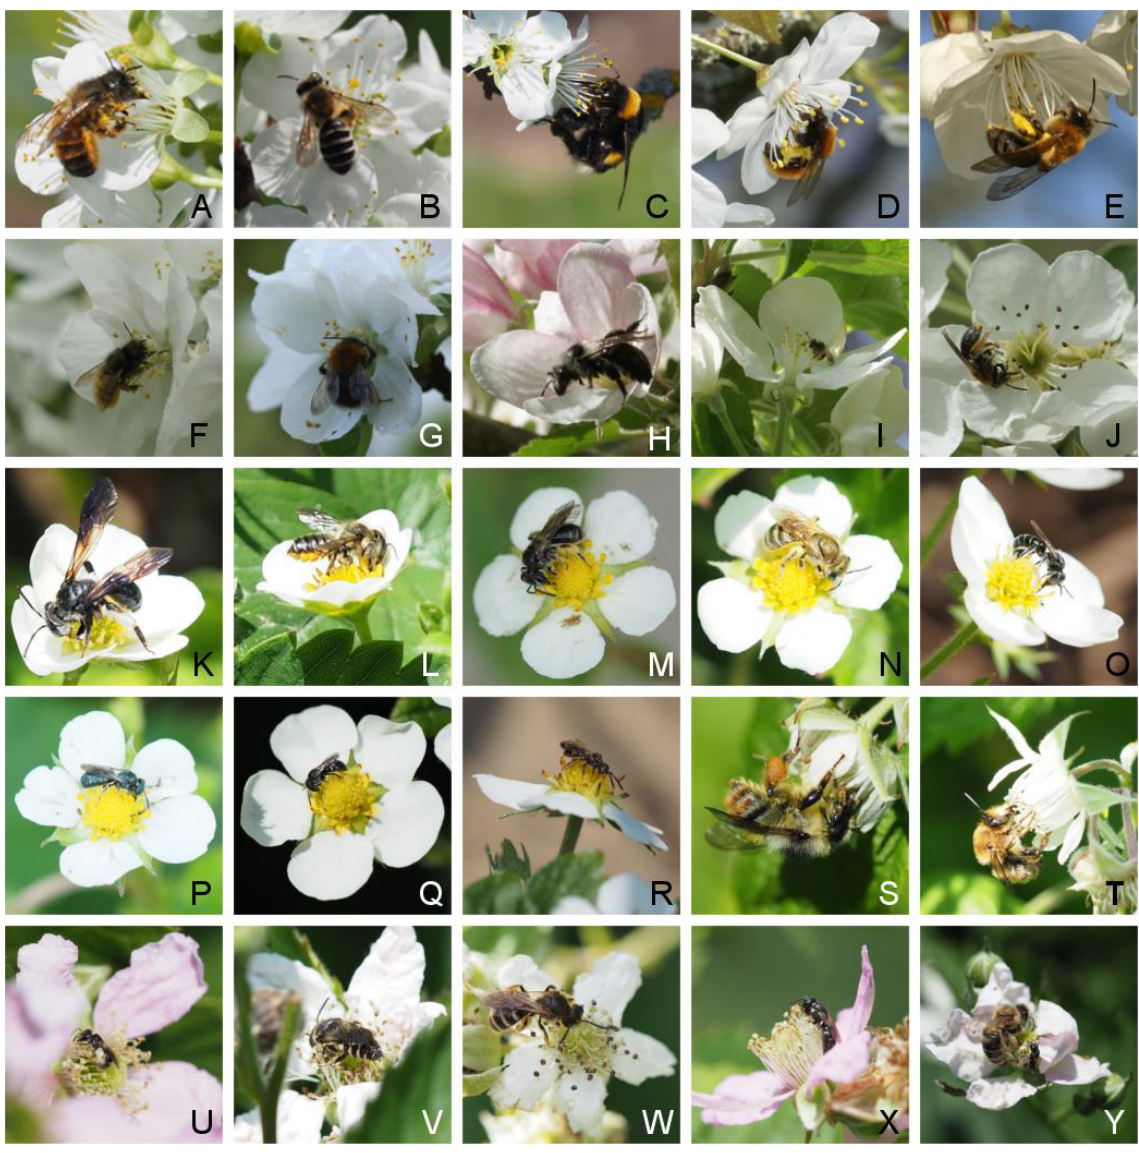
Figure 3. Some of the bee species observed on the target crops: Osmia bicornis (A), Andrena cf. flavipes (B) and Bombus terrestris agg. (C) on plum; Andrena fulva (D) and Andrena nitida (E) on cherry; Osmia cornuta (F), Bombus hypnorum (G), Andrena cineraria (H) and Andrena cf. minutula (I) on apple; Andrena haemorrhoa (J) on pear; Andrena agilissima (K), Megachile cf. centuncularis (L), Andrena cf . minutula (M), Halictus subauratus (N), Osmia leucomelana (O), Ceratina cyanea (P), Stelis cf. ornatula (Q) and Nomada cf. flavoguttata (R) on strawberry; Bombus sylvarum (S), Anthophora furcata (T) and Lasioglossum politum (U) on raspberry; Coelioxys cf. aurolimbata (V), Lasioglossum cf. calceatum (W), Hylaeus cf. hyalinatus (X), Apis mellifera and Hylaeus cf. confusus (Y) on blackberry (slightly different scales; A-C, K-Y Ⓒ J. W., D-J Ⓒ I.